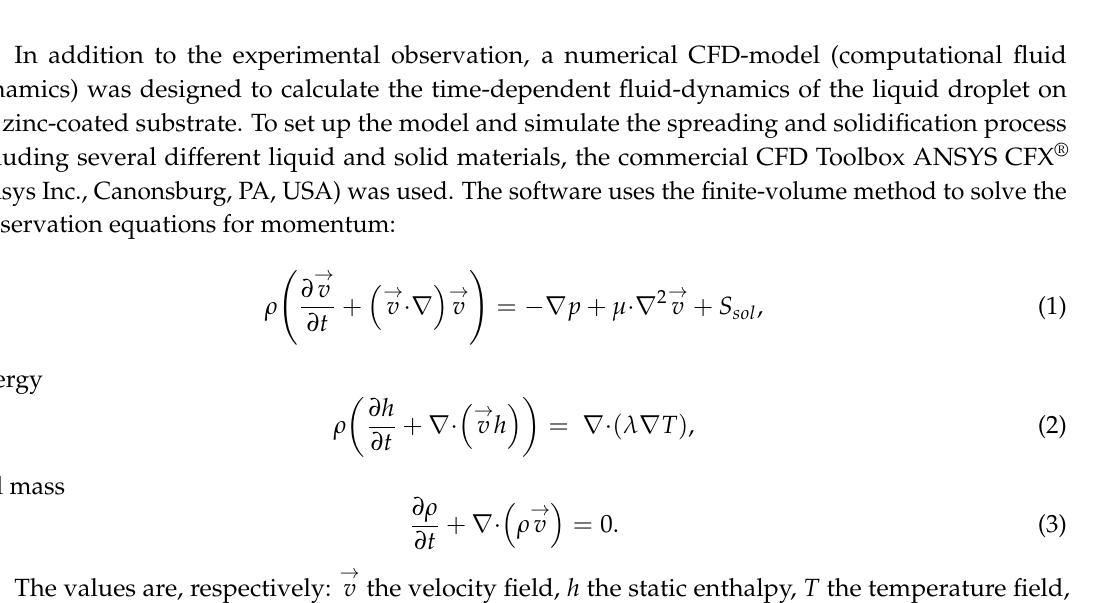
Figure 1. ( a ) Experimental model system for single droplet wetting observation; ( b ) numerical model system and initial conditions for the simulation of single-droplet wetting.